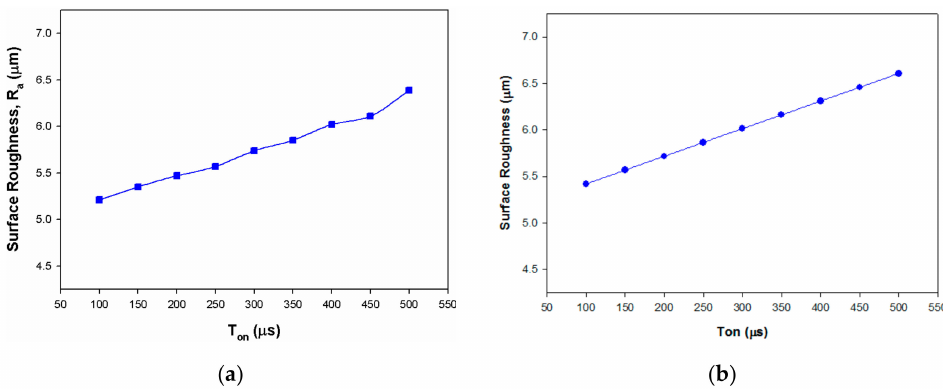
Figure 9. Main effect plots for SR with T on using ( a ) DOE model; ( b ) machine learning